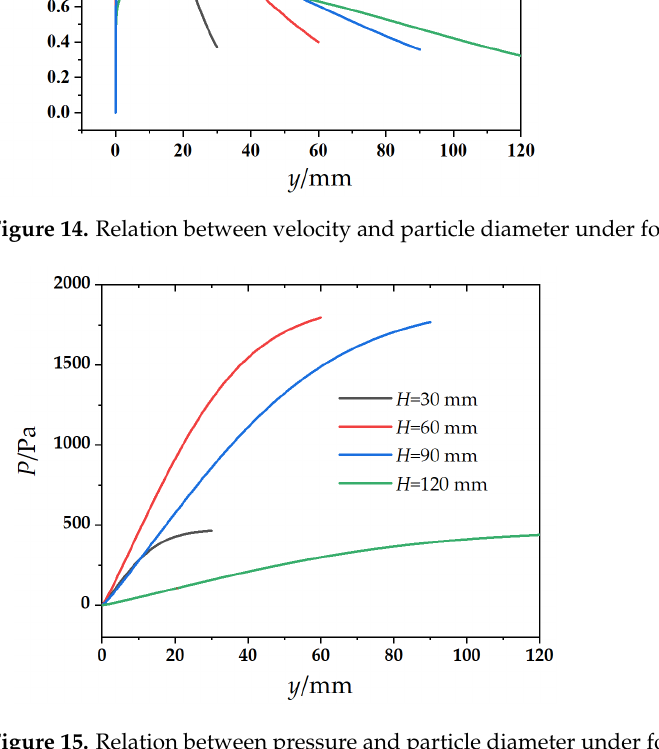
Figure 15. Relation between pressure and particle diameter under four different H / d p .